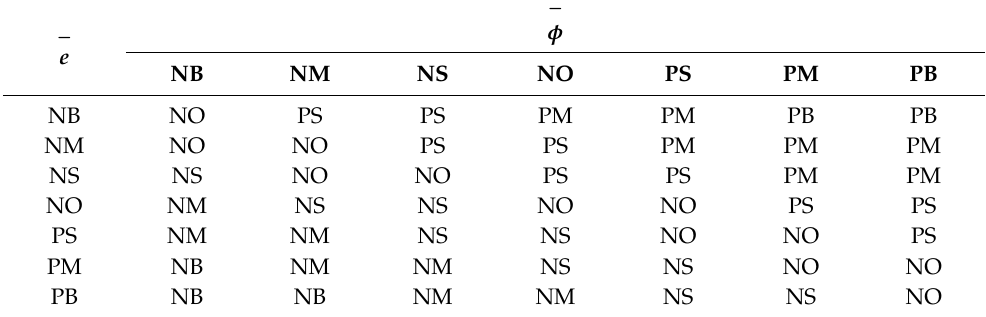
Table 1. Fuzzy control rules of Table 2. Fuzzy control rules of ς y .